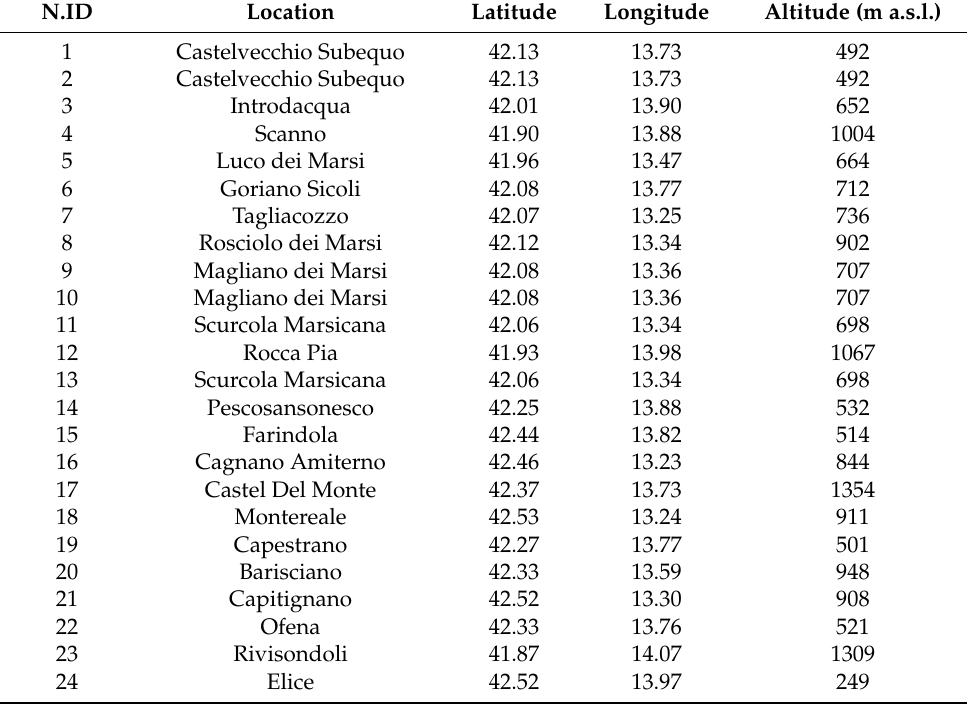
Table 7. Solina accessions used in the study. Each accession is identified by a number and the sampling location is reported, together with geographical